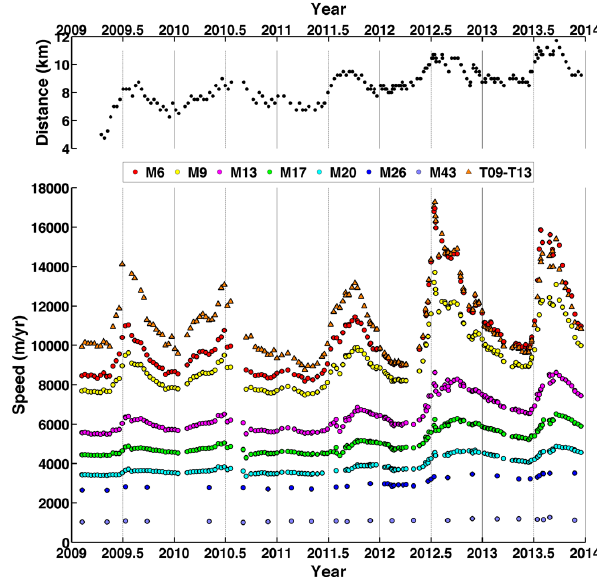
Fig. 2. Plots of (top) terminus position and (bottom) speed through time for Jakobshavn Isbræ determined from TerraSAR-X data col- lected from 2009 to 2013. Terminus position was digitized where it intersects the white profile shown in Fig. 1. The colour circles (M6–M43) show the speed at several points along the glacier’s main trunk at the locations shown in Fig. 1 (M26 and M43 locations not shown; see Joughin et al., 2008). Each point’s numerical designa- tion (e.g. M6) gives the approximate distance in kilometres from glacier terminus in late summer 2003 and these points are used for consistency with earlier records (Joughin et al., 2008, 2012b). Ad- ditional markers, T09–T13 (orange triangles) (locations shown in Fig. 1), are each situated 1km upstream of the terminus at its posi- tion of maximum retreat for the years 2009–2013. Each year, speeds are plotted for the corresponding point